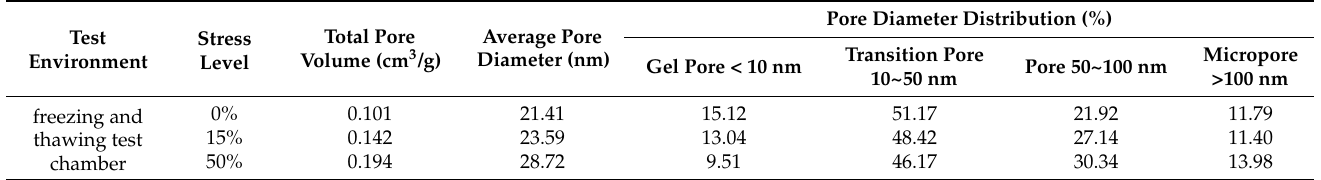
Table 5. Influence of test environment and stress level on the pore structure of the